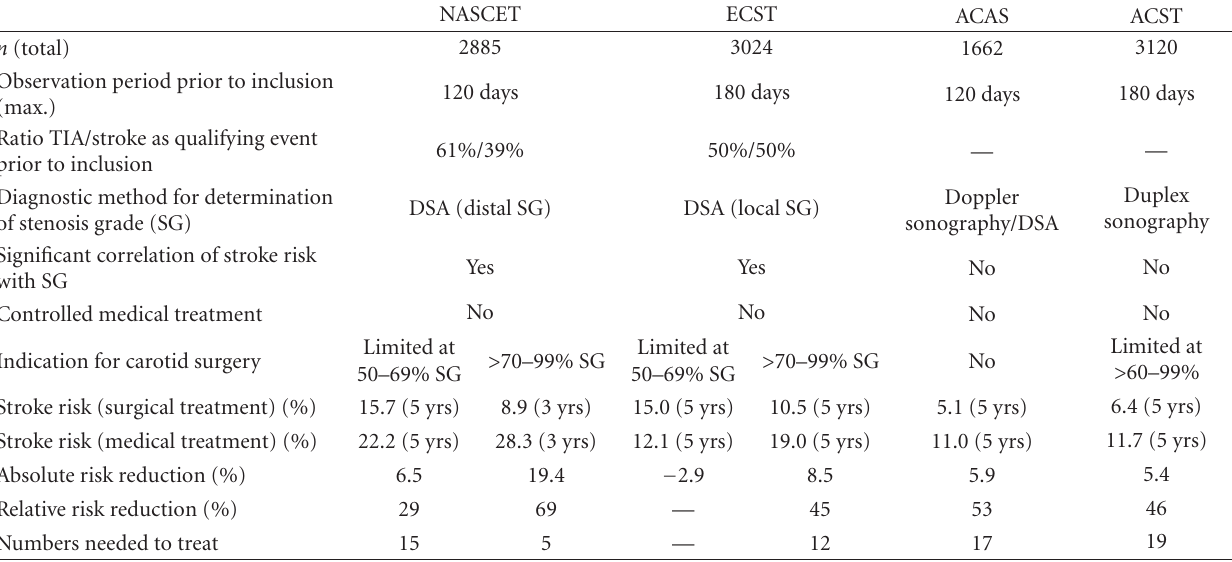
Table 1: Outline of the most important characteristics and results of large carotid surgery trials. DSA: digital substraction